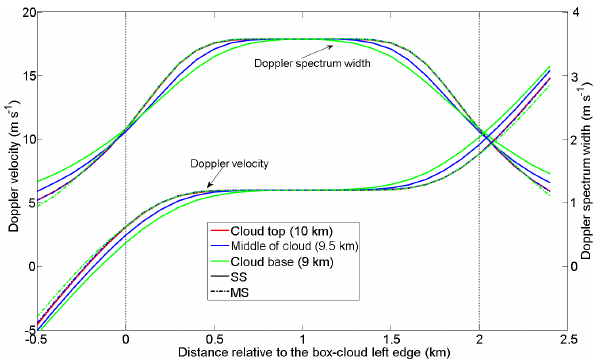
Figure 8. MS (full lines) and SS (dotted line) apparent Doppler velocity and Doppler spectrum width as a function of the distance of the satellite relative to the box-cloud left edge. Values are computed at cloud top (10km of altitude, in red), middle (9.5km of altitude, in blue), and base (9km of altitude, in green). Optical thickness of the box cloud is 3. Simulations are done every